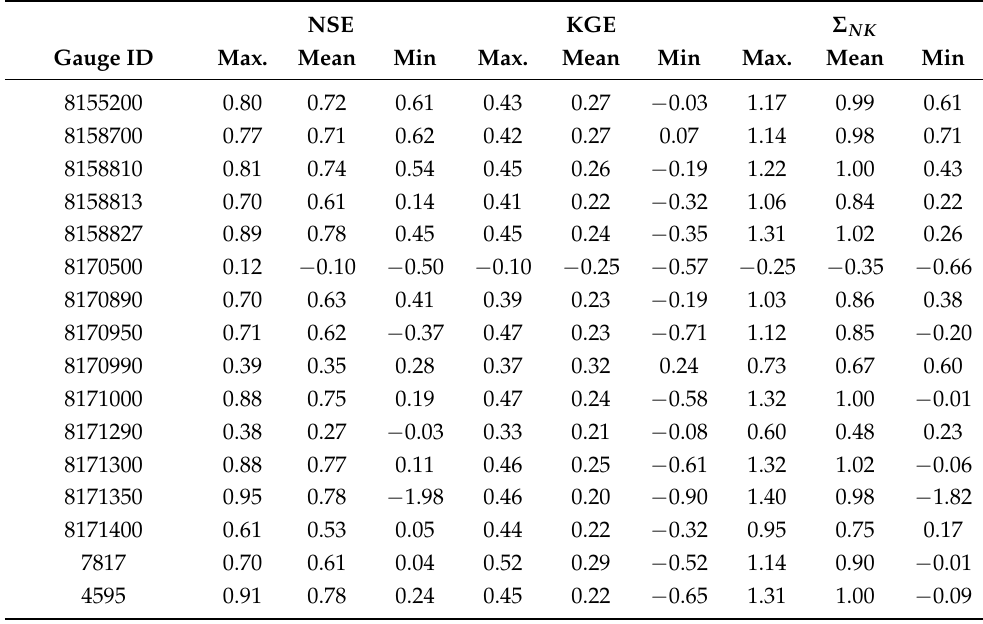
Table 4. Daily ‘goodness-of-fit metrics’ between gauge discharge and synthetic, biased discharge time series. NSE KGE Σ NK Gauge ID Max. Mean Min Max. Mean Min